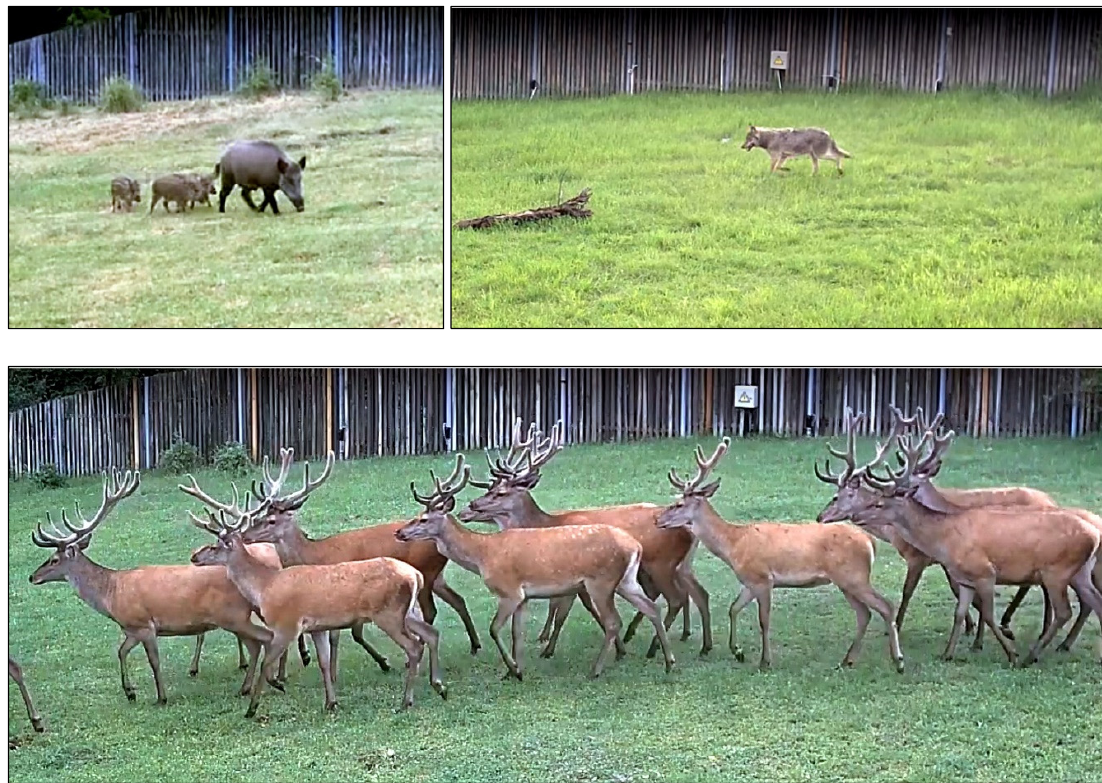
Figure 12. Migration of boars, wolves and red deer using the wildlife overpass over national road no. 5 in the Greater Poland National Park (screenshots from the monitoring footage [115]).